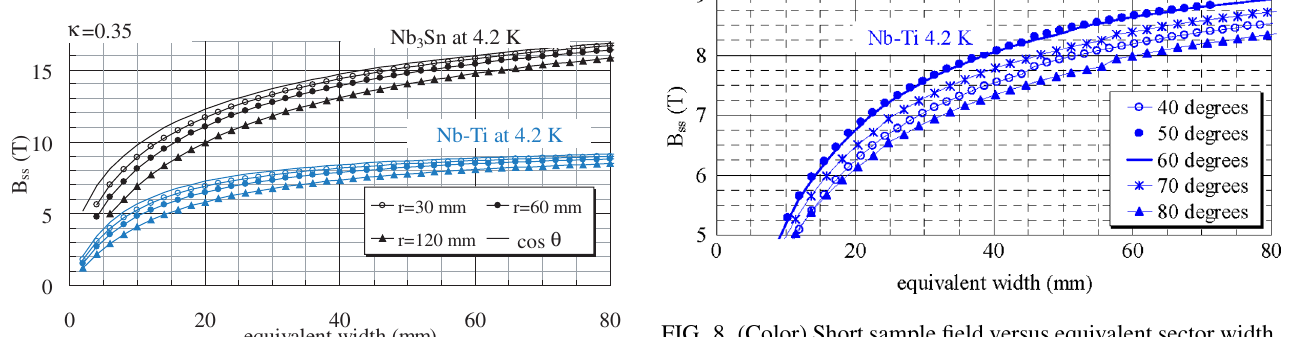
FIG. 8. (Color) Short sample field versus equivalent sector width for different angular widths of the sectors for an aperture radius of 30 mm, Nb-Ti case. Note that 50 (cid:12) and 60 (cid:12) curves are over- lapping.